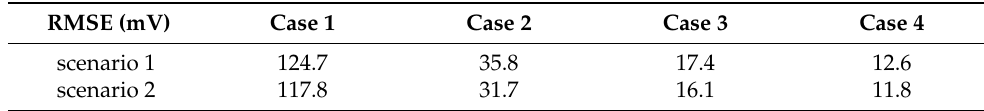
Figure 11. Validation results for for all cases with ( a ) the voltage profile in scenario 1, ( b ) voltage error in scenario 1, ( c ) voltage profile in scenario 2, and ( d ) voltage error in scenario 2. Table 7. Calculated RMSE values for the validation of each